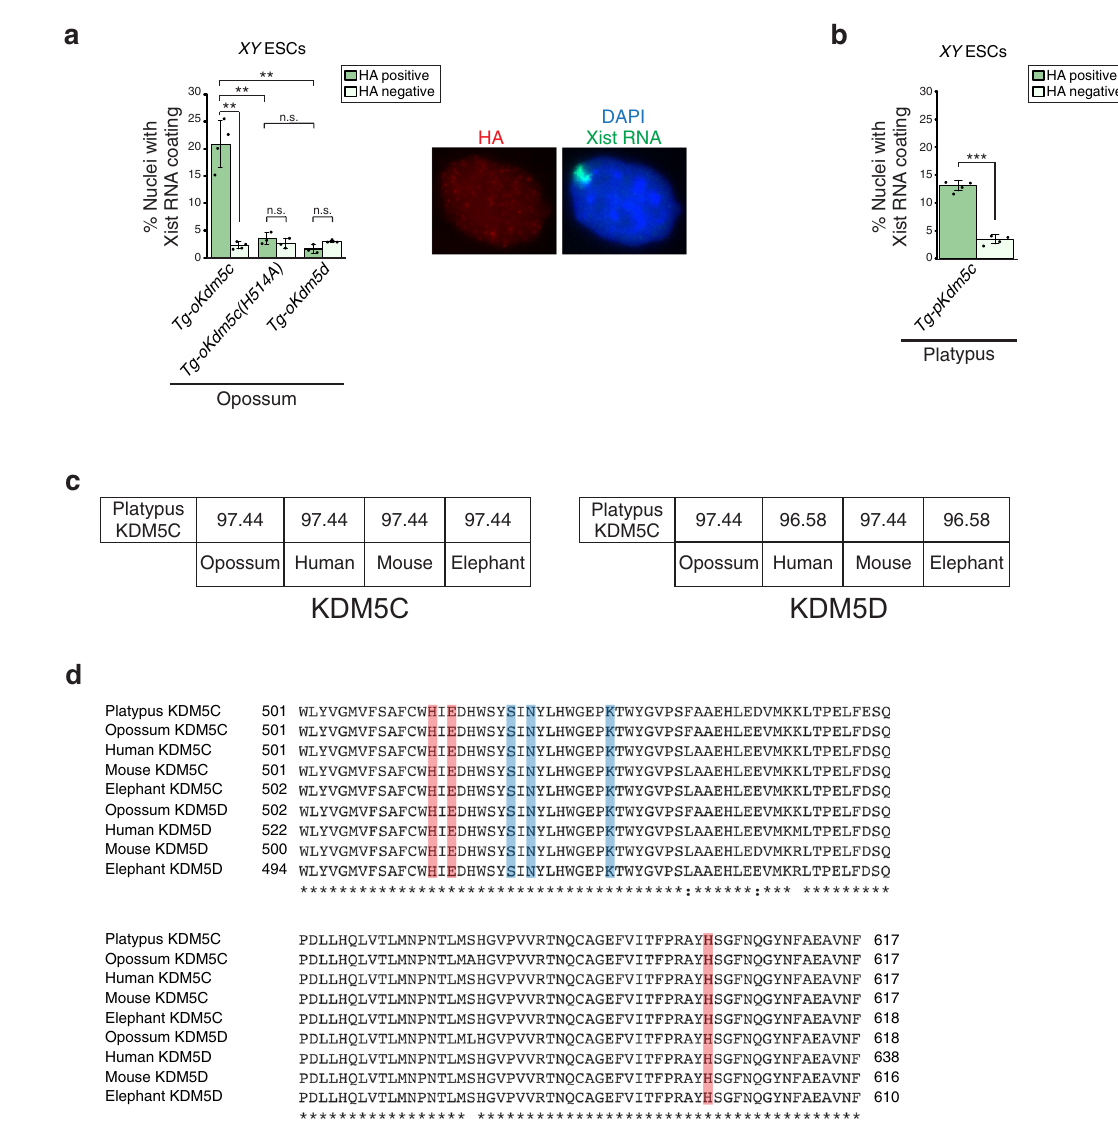
Fig. 8 Opossum and platypus KDM5C activate Xist in male mouse ESCs. a Quanti fi cation of nuclei with Xist RNA coating in each of three independent transgenic ( Tg ) XY ESC lines expressing HA-tagged opossum KDM5C ( Tg-oKdm5c ; n = 209, 618, and 306); enzymatically inactive KDM5C protein ( Tg-oKdm5c(H514A) ; n = 196, 206, and 193); and, KDM5D ( Tg-oKdm5d ; n = 803, 562, and 636). Data are presented as mean ± SEM. P values, Welch ’ s two-sided t test. n.s., not signi fi cant; * P ≤ 0.05; ** P < 0.01; *** P < 0.001. See Supplementary Table 9 for all pairwise statistical comparisons. b Quanti fi cation of nuclei with Xist RNA coating in each of three independent transgenic ( Tg ) XY ESC lines expressing HA-tagged platypus KDM5C ( Tg-pKdm5c ; n = 202, 178, and 525). Data are presented as mean ± SEM. P values, Welch ’ s two-sided t test. *** P < 0.001. See Supplementary Table 9 for pairwise statistical comparisons. c Percent amino acid identity between the catalytic JmjC domain of platypus KDM5C and therian KDM5C (left) or platypus KDM5C and therian KDM5D proteins (right). d Multiple sequence alignment of the demethylase JmjC domain of KDM5C and KDM5D proteins. The predicted iron- binding and the α -ketoglutarate-binding amino acids required for the catalytic activity of KDM5C/D are shown in orange and blue 55,76,102,103 , respectively. Source data are provided as a Source Data fi